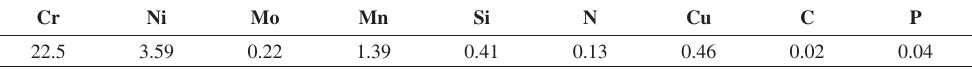
Table 1. Chemical composition of lean duplex UNS S32304 investigated in this work (%wt.).